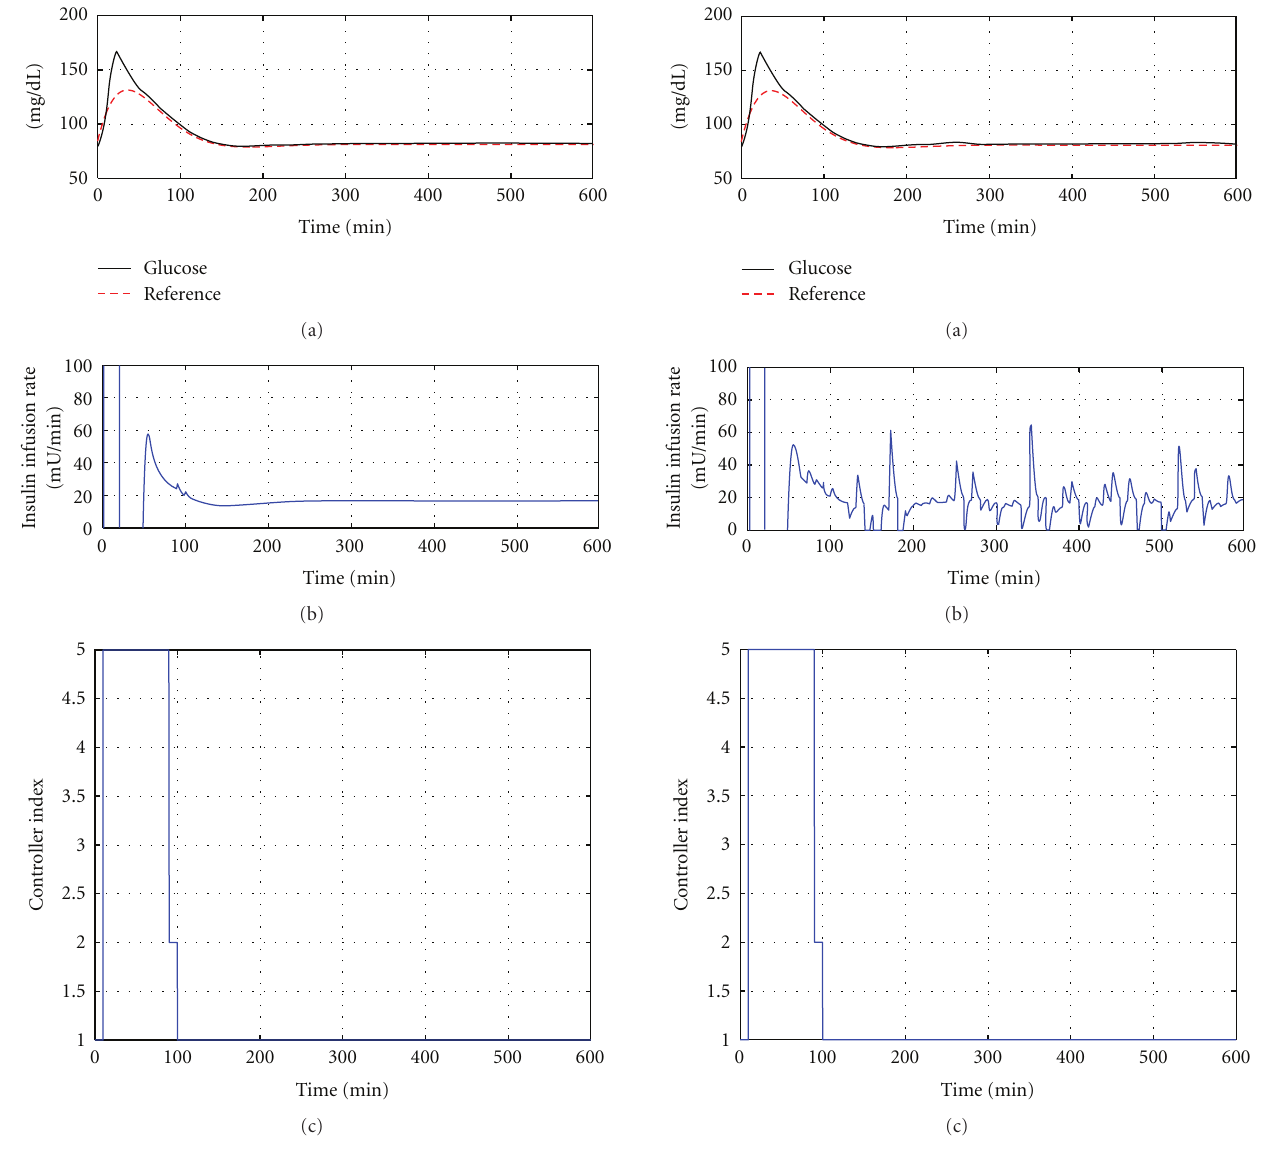
Figure 7: Unfalsified control: glucose monitoring, insulin control and controller switching under measurement